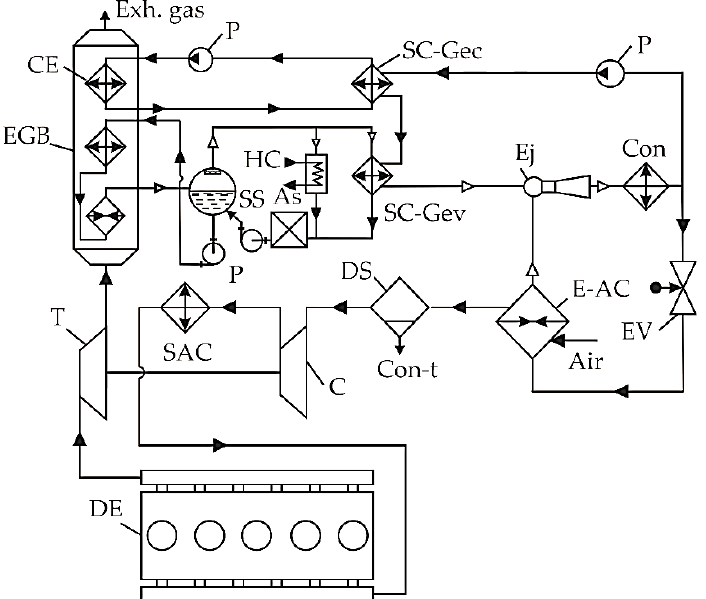
Figure 4. Scheme of the system for cooling the air at the suction of engine turbocharger by recovering the heat of exhaust gas: DE—diesel engine; T—turbine and C—compressor of turbocharger; SAC— scavenge air cooler; EGB—exhaust gas boiler; Gev—evaporative section of generator consuming steam condensed; Gec—economizer section of generator consuming hot water;